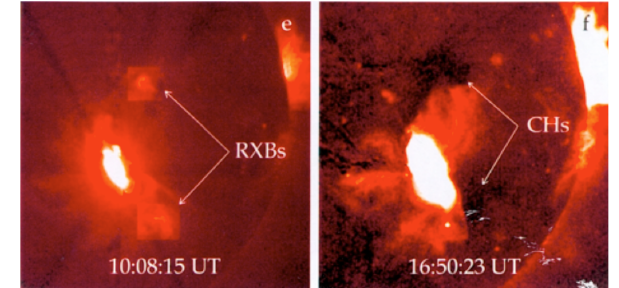
Fig. 6. From Manoharan et al. (1996) showing the consequences of interaction between a CME and overlying TELs on 25 October 1994: formation of X-ray brightenings (RXBs, left panel) followed by the appearance of coronal dimmings (CHs) at the same location. Extensive loop formation between the flaring AR and the edge of the dimming regions (Yohkoh SXT data) was also observed.